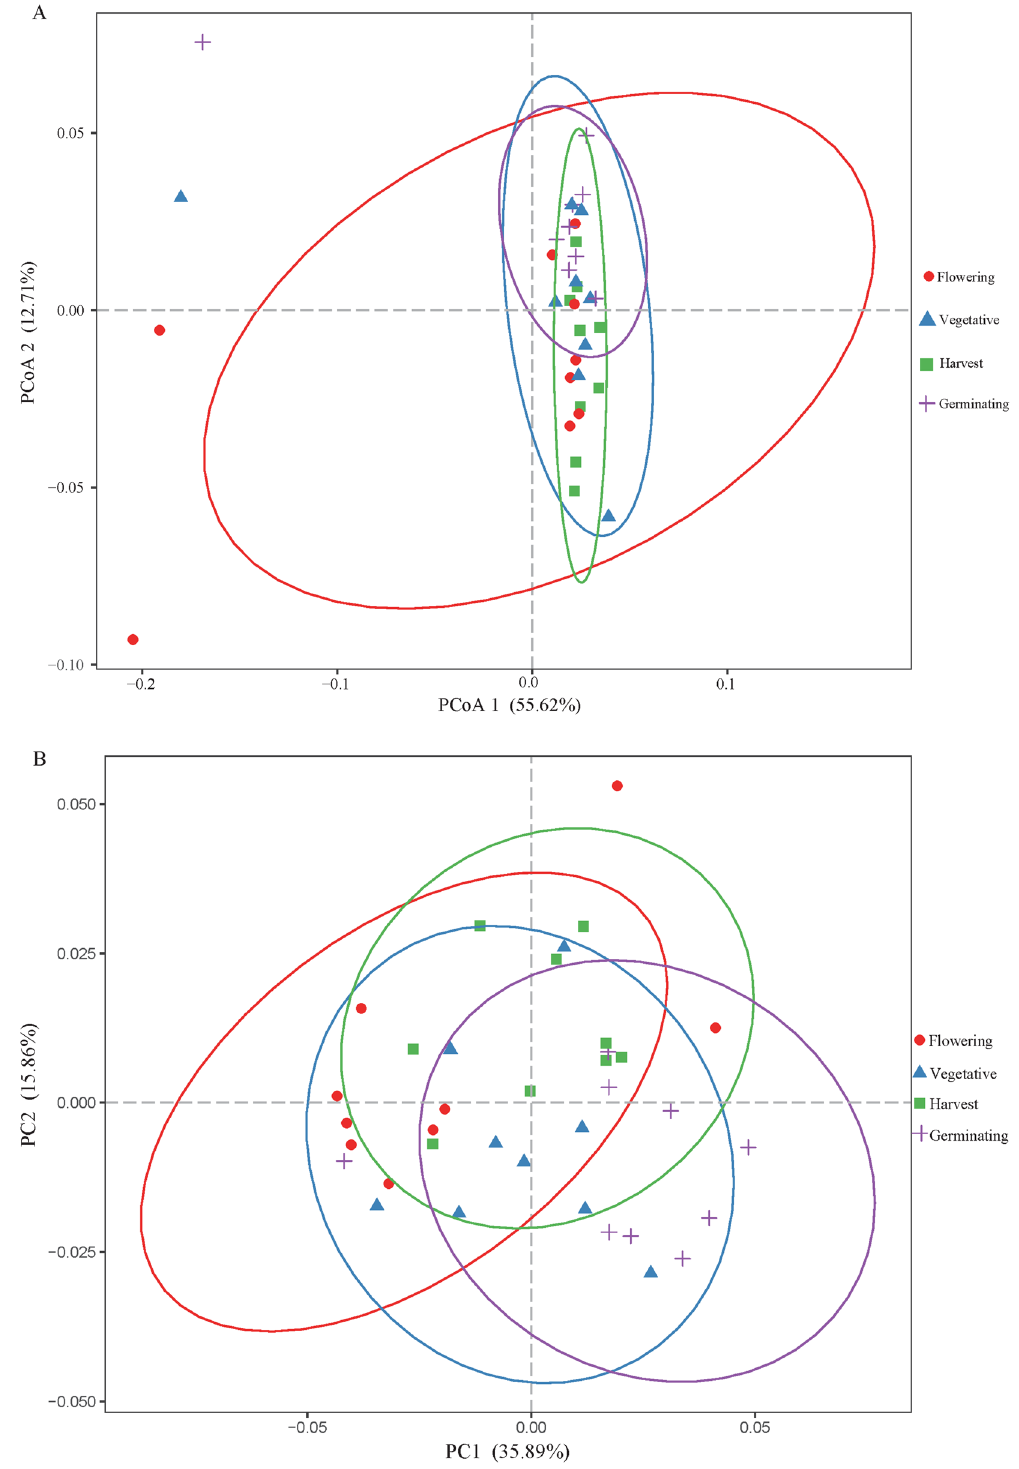
Figure 3. Factors influencing rhizosphere prokaryotic β-diversity. Variation in unweighted UniFrac dispersion ( A ) and weighted UniFrac dispersion ( B ) based on each developmental stage of Potentilla anserina ( p <